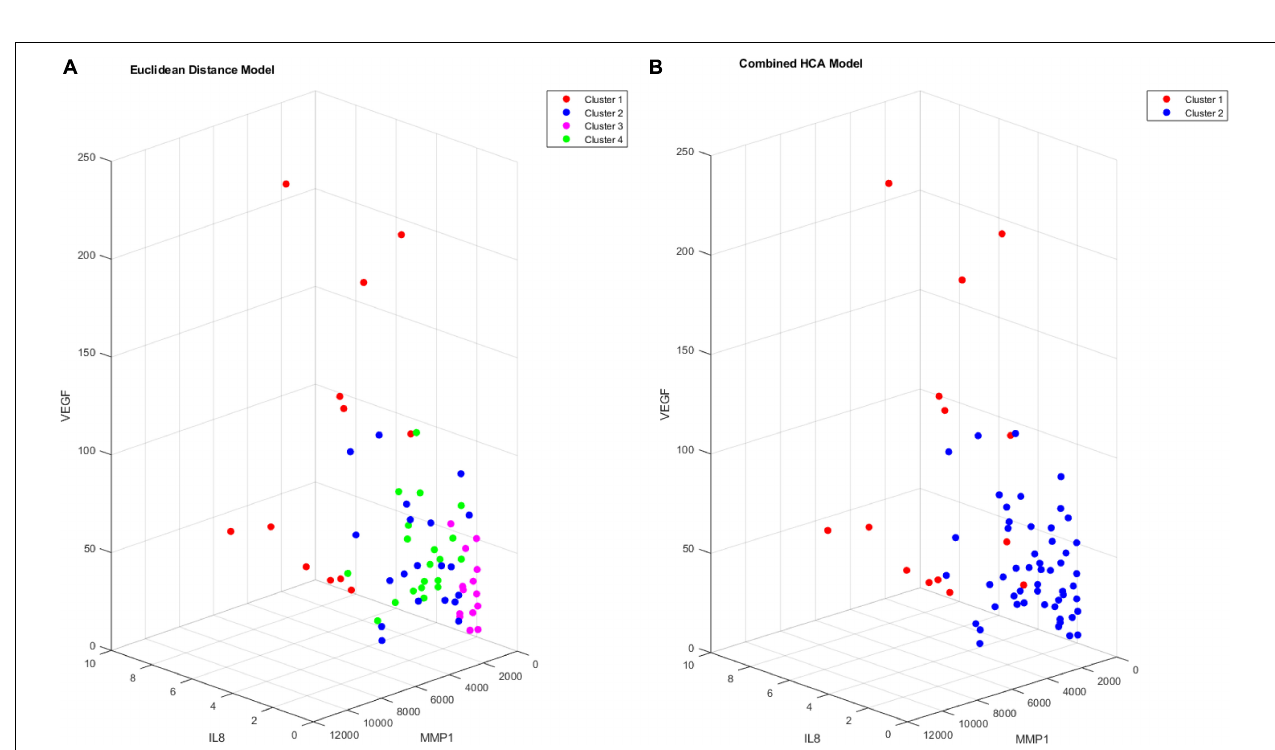
FIGURE 6 | Cluster comparison of VEGF (pg/mL), MMP1 (pg/mL), and IL8 (pg/mL) for data clustered using the Euclidean distance model (A) and the combined HCA model (B) from 66 participant plasma samples.